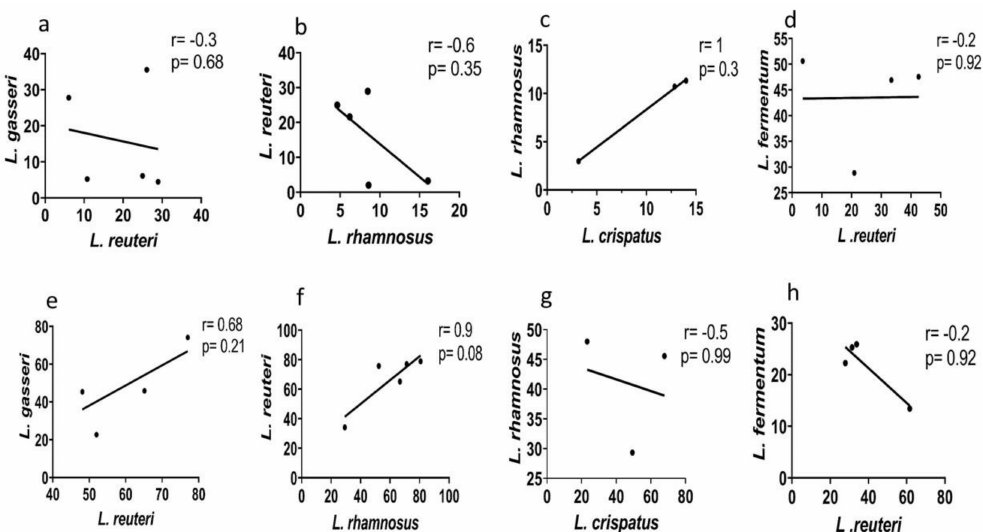
Figure 5. Correlation between Lactobacillus species from normal microbiota in d -lactic acid production (a to d- top panel) ( a ) L. gasseri with L. reuteri , ( b ) L. reuteri with L. rhamnosus , ( c ) L. rhamnosus with L. crispatus , ( d ) L. fermentum with L. reuteri and l - lactic acid production (e to h- bottom panel)